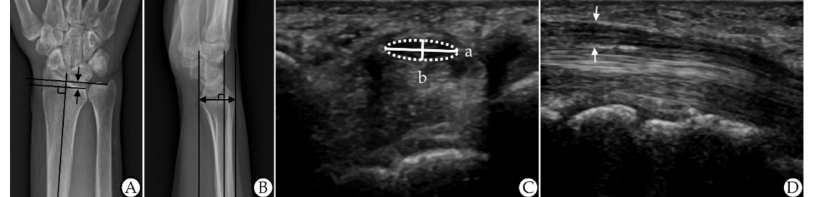
Figure 2. Measurements of ultrasonographic and roentgenographic features. ( A ) Ulnar variance on X-rays (the distance between the two arrows). ( B ) AP diameter of the wrist on X-rays (the distance of the arrow). ( C ) Flattening ratio on US (a (width)/b (height)). ( D ) Thickest AP diameter of the median nerve on US (the distance between the two arrows). Abbreviations: AP, anteroposterior; US,